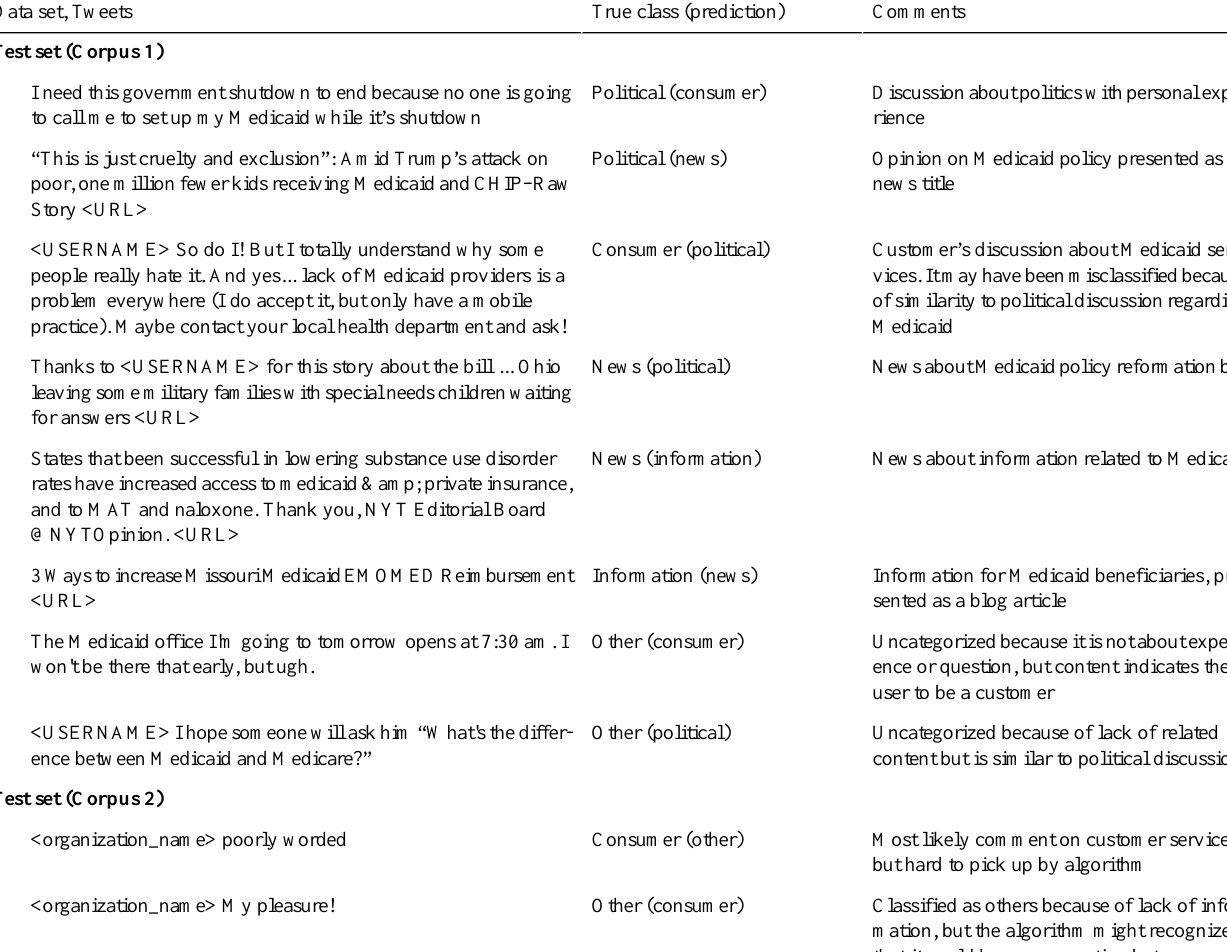
Table 4. Examples of misclassified tweets by the BERT classifier on Corpus 1 and Corpus